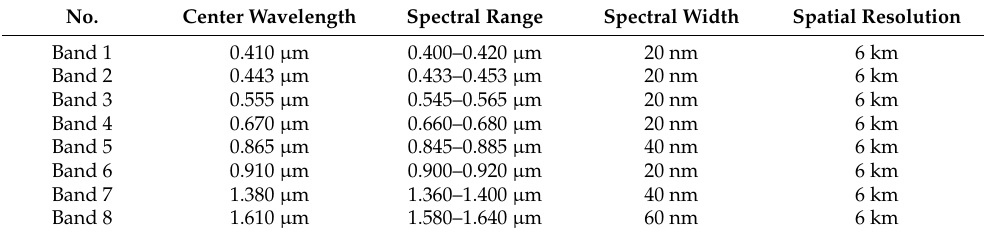
Table 1. The specific band settings of the polarized scanning atmospheric corrector (PSAC).